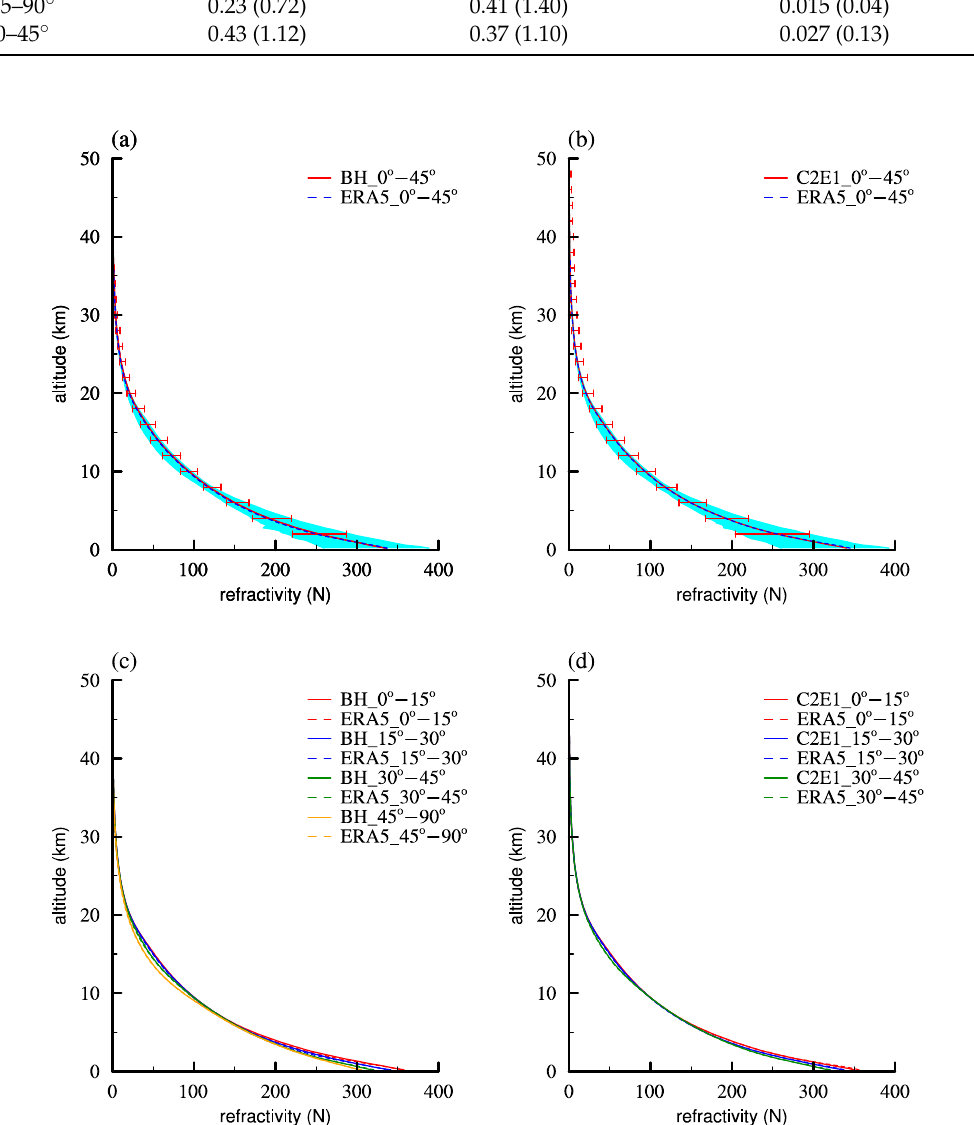
Figure 4. Vertical profiles of the average refractivity (units: N) for the BH, C2E1, and ERA-5 data at different latitudes. ( a , c ) BH and ERA-5 data; ( b , d ) C2E1 (red) and ERA-5 data. The bars indicate the range of BH ( a ) and C2E1 ( b ) refractivity values. Shadings in ( a , b ) indicate the range of ERA-5 refractivity values. Table 1. The average absolute bias and STD for BH and C2E1 RO data at latitudes of 0–45° and 45– 90°. The numbers in parentheses indicate STD values.